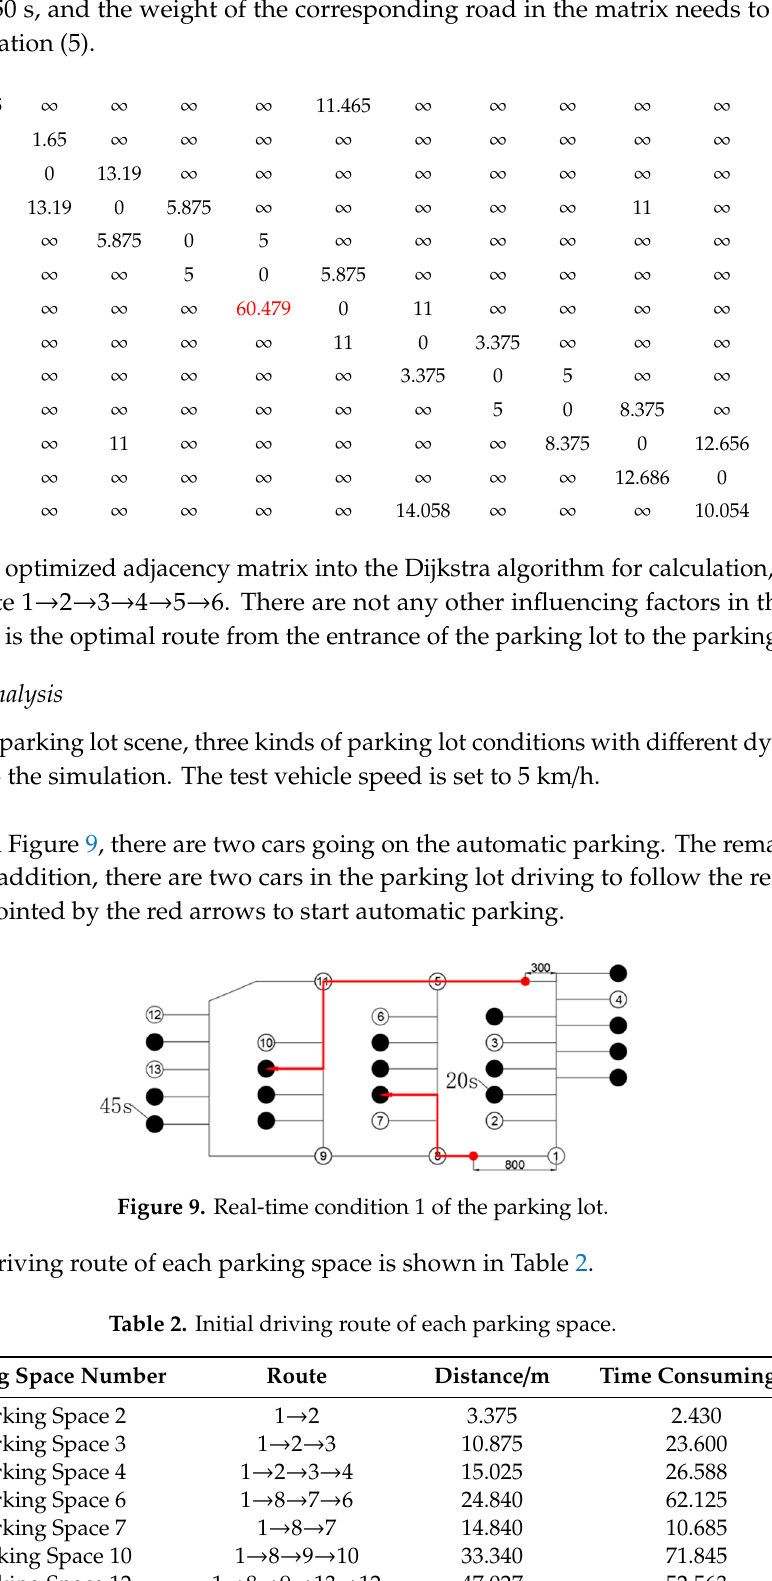
Table 2. Initial driving route of each parking space.